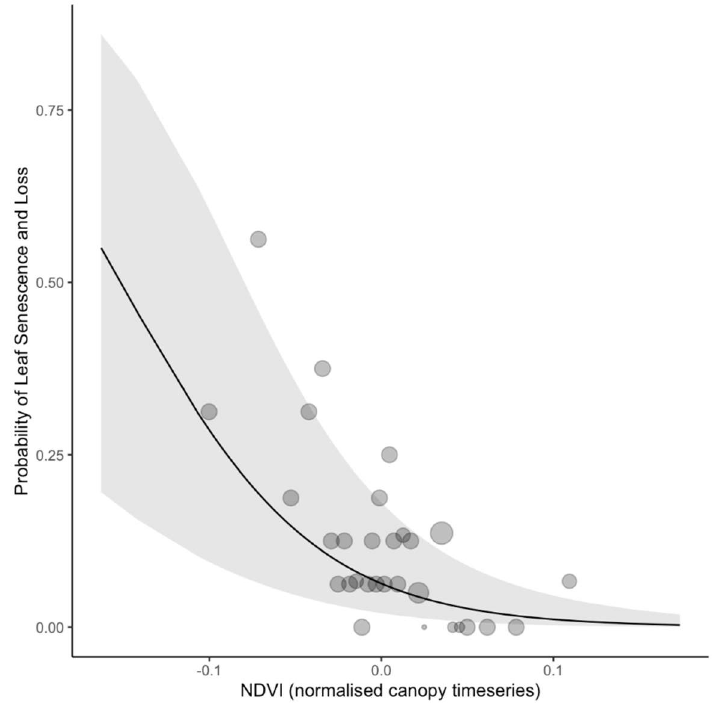
Figure 4. Detecting leaf senescence and loss using satellite data. Standardized estimates (dots) and 95% confidence intervals (lines) from eight single variate generalized linear mixed models (binomial) for the probability of detecting leaf senescence and loss from focal canopy time series (mean value of all pixels within canopy) and normalized canopy time series (difference between the mean value of all pixels within the canopy and the mean value of all pixels in the surrounding forest buffer) of the VV and VH bands of the Sentinel-1 synthetic aperture radar (SAR) data and the normalized difference vegetation index (NDVI) and the green leaf index (GLI) derived from Sentinel-2 optical data. Mixed models included tree ID and year as random effects.